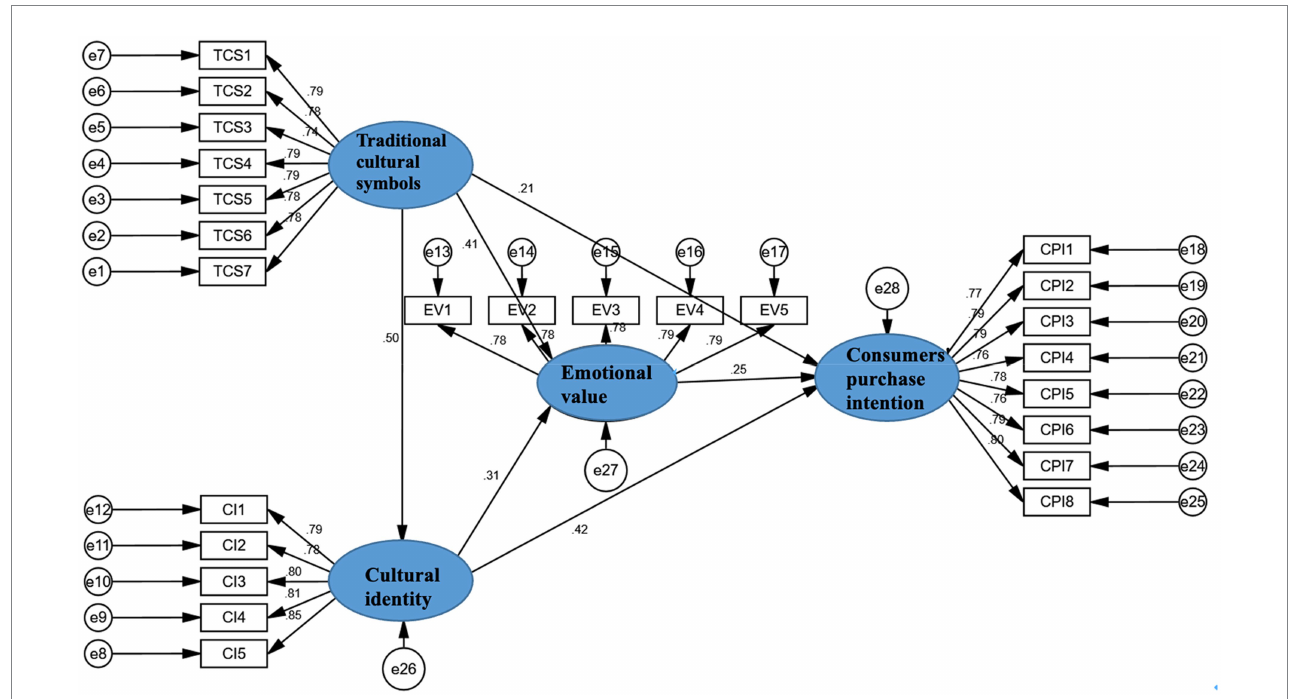
FIGURE 2 The original edition of structural equation modeling.